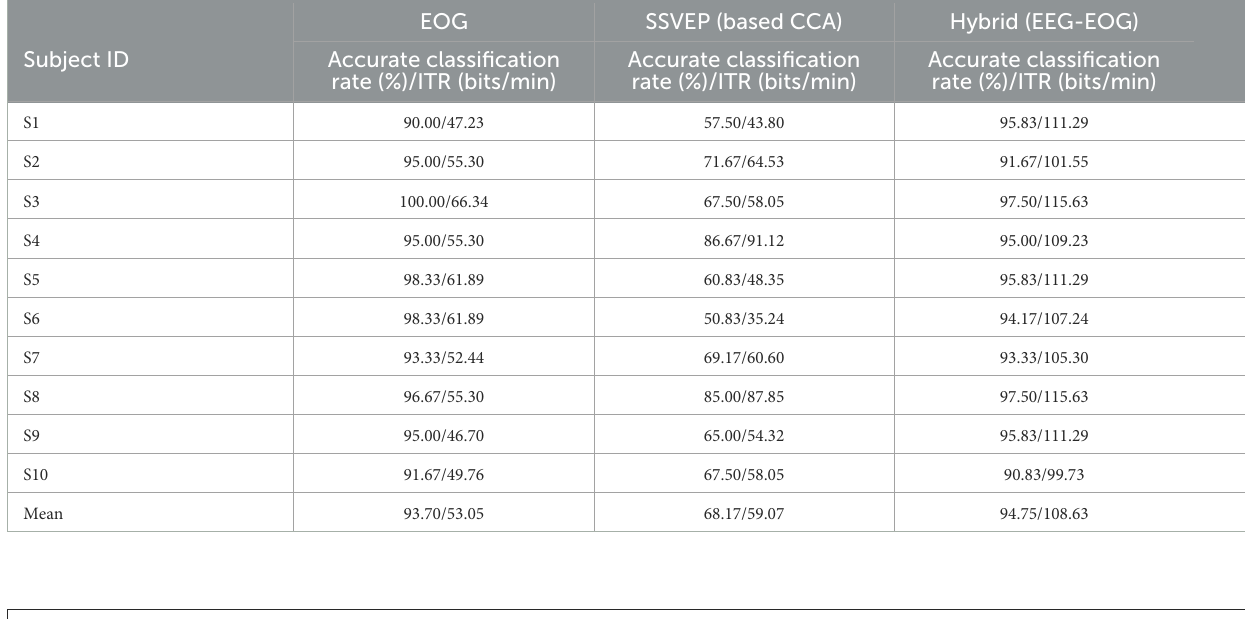
TABLE 1 Experimental results of online systems: accurate classification rate and ITR for EOG-only, SSVEP-only and hybrid systems.